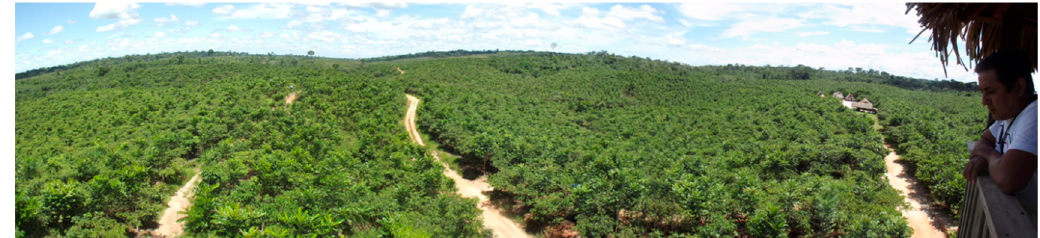
Figure 22. View of the Campo Verde reforestation on degraded areas.